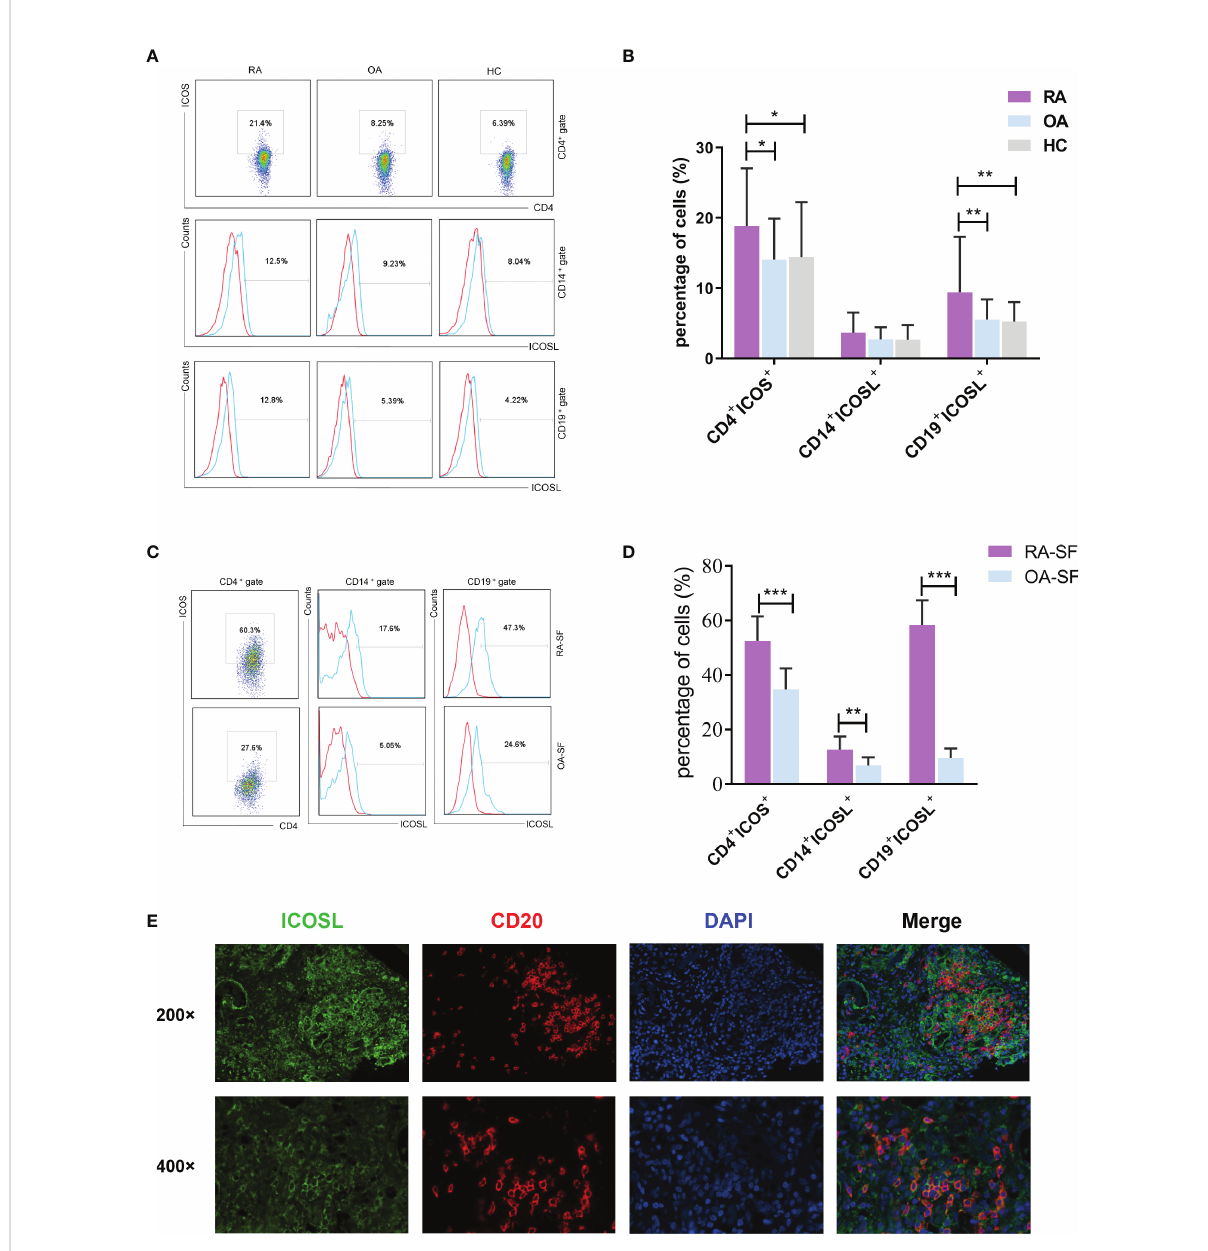
FIGURE 1 Expression of ICOS and ICOSL in patients with RA. (A) The expression of ICOS and ICOSL in PB samples of patients with RA, patients with OA and HCs by fl ow cytometry. (B) Percentages of CD4 + ICOS + , CD14 + ICOSL + and CD19 + ICOSL + cells in PB samples of patients with RA (n = 67), patients with OA (n = 40) and HCs (n = 40). (C) The expression of ICOS and ICOSL in SF samples by fl ow cytometry. (D) Percentages of CD4 + ICOS + , CD14 + ICOSL + and CD19 + ICOSL + cells in SF samples of patients with RA (n = 8) and patients with OA (n = 10). (E) Immuno fl uorescence staining of ICOSL and CD20 in synovial tissues of RA patients (green for ICOSL, red for CD20, blue for DAPI). Bars indicate mean ± SD; * P < 0.05, ** P < 0.01, *** P <